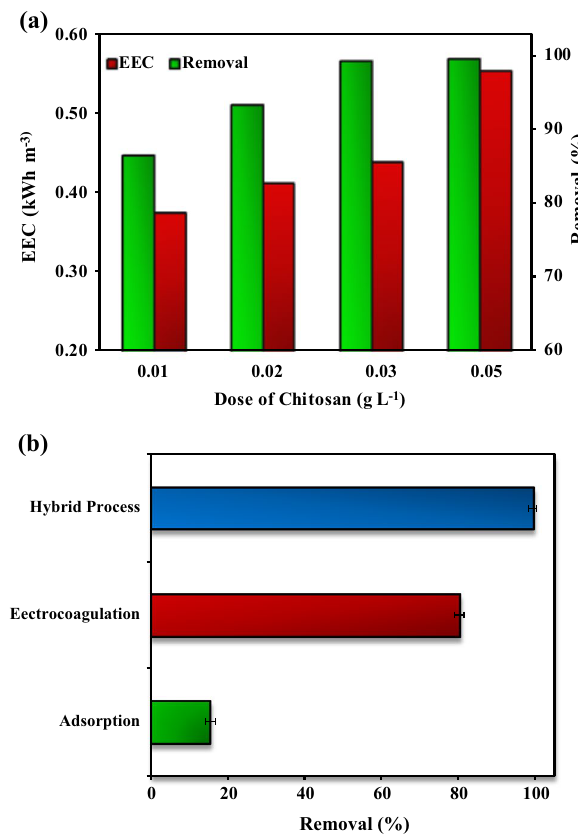
Fig. 6 a Removal efficiency and EEC during the treatment process under different chitosan dosages. b contribution of electrocoagula- tion, adsorption, and hybrid process for the HDZ removal